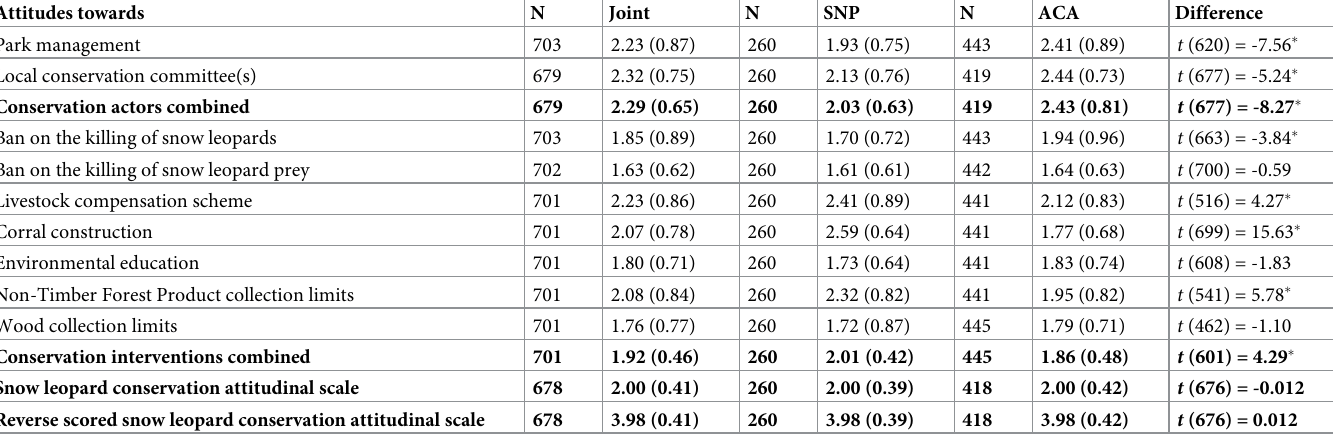
Table 4. Mean attitudes to snow leopard conservation in the combined sample from Sagarmatha National Park (SNP) and Annapurna Conservation Area (ACA), also showing differences in attitudes between sites. Attitudes towards